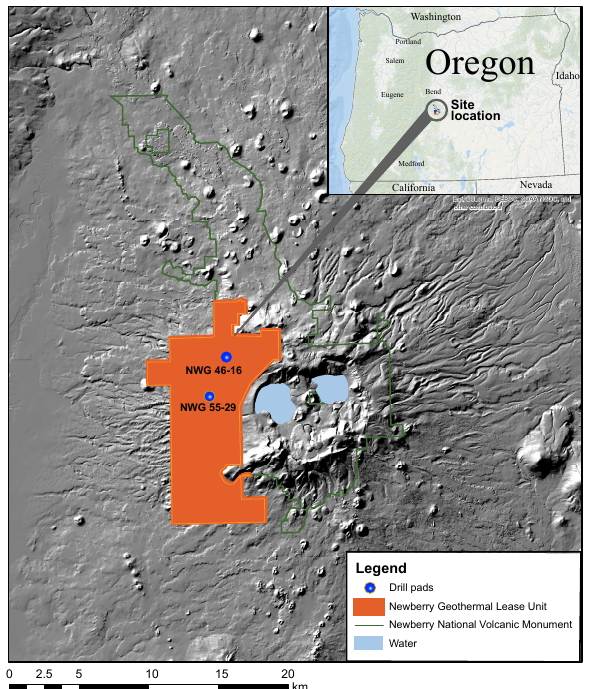
Figure 2. Location of the proposed NDDP well at NWG 46-16. Well NWG 55-29, the Newberry National Volcanic Monument and the geothermal lease are also